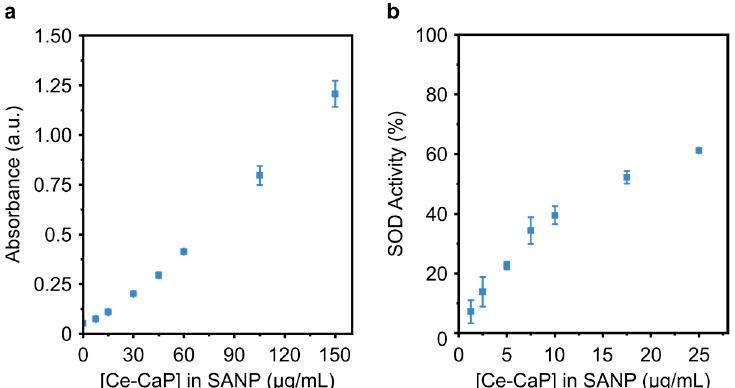
Figure 6. Peroxidase- and SOD-like activity of Ce-SANP. ( a ) Absorbance of the reaction product measured at 451 nm with varying concentrations of Ce-SANP. Ce-SANP were added to the TMB substrate solution and the reaction was stopped after 1 min with the addition of a stop solution. Data points are represented as mean ± s.d. (N = 5 independent batches, n = 3 technical replicates). ( b ) SOD-like activity of Ce-SANP as a function of their concentration. Ce-SANP were added to a solution containing xanthine oxidase and tetrazolium salt; the mixture was incubated at 37 °C for 20 min, after which the absorbance at 450 nm was recorded. Data points are represented as mean ± s.d. (N = 3 independent batches, n = 3 technical replicates).